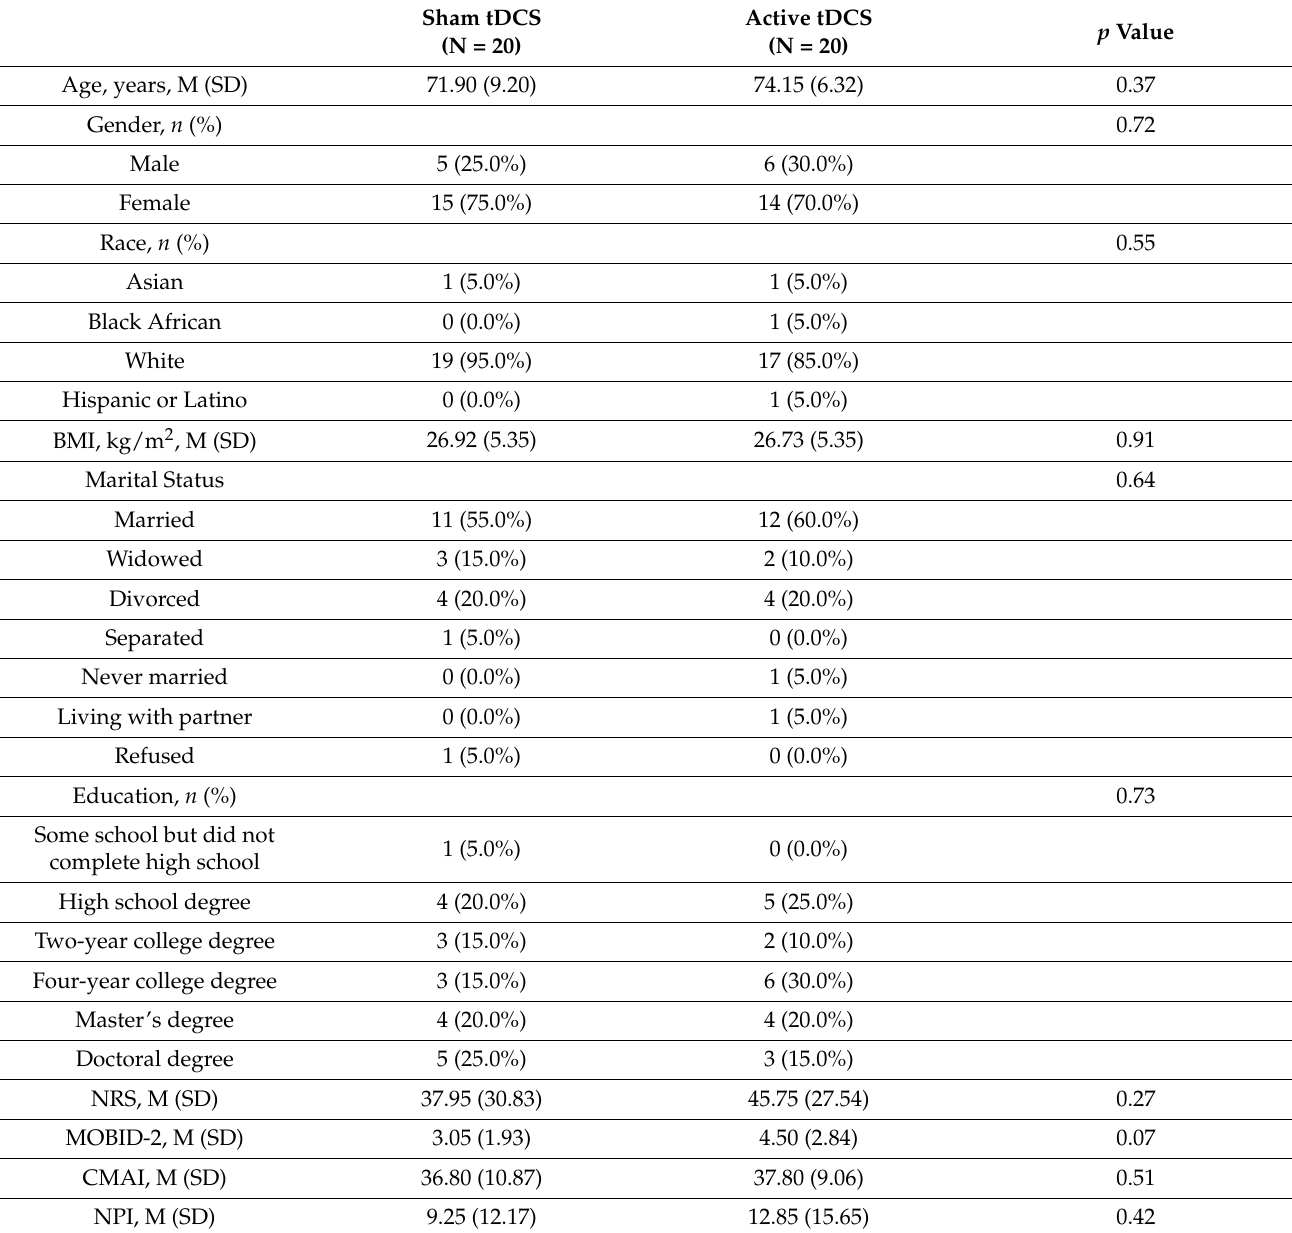
Table 1. Baseline Demographic and Clinical Characteristics of the